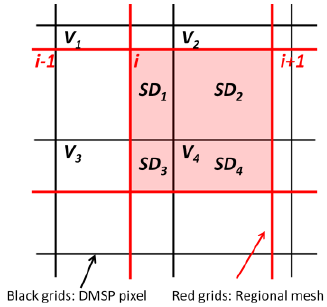
Figure 1. Spatial gap between DMSP/OLS pixels and the Regional Meshes R B means with intermittent light, and R C means with few light affecting road traffic. Values in parentheses are road with light blocking structures on median zone. Values in Table 2 are decided by Table 1. In urban area, this value set as large as possible and in rural area, it set as small as possible.*1 in Table 2 are 0 in Table 1, however they are set 0.1 in this study because it is expected that they emit a weak light from street lamps in some intersections. Estimated light intensity by road in each Regional Mesh is defined as equation 3 based on road length in each Regional Mesh and values in Table 2.